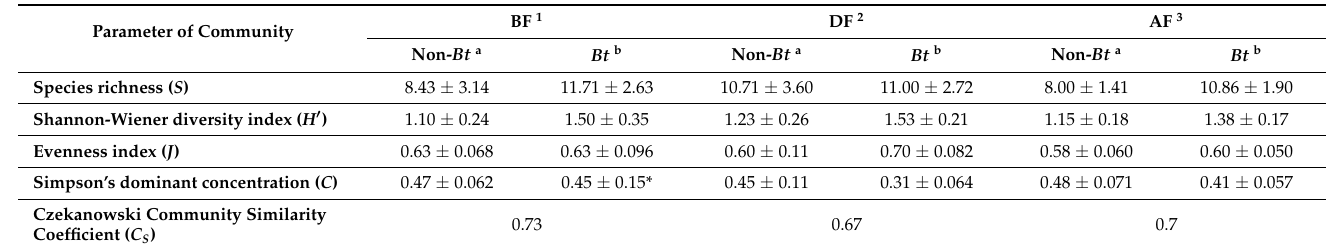
Table 2. Comparison of community parameters for arthropods between fields planted with Bt maize or non- Bt maize. Values represent means ± SE, n = 7 replicates. The differences in the same maize fields among months were analyzed by a one-way ANOVA followed by the Tukey HSD test (all p > 0.05). The differences of the community parameters of arthropods between Bt and non- Bt maize fields were analyzed by a Student’s t -test (an asterisk denotes a significant difference, p <